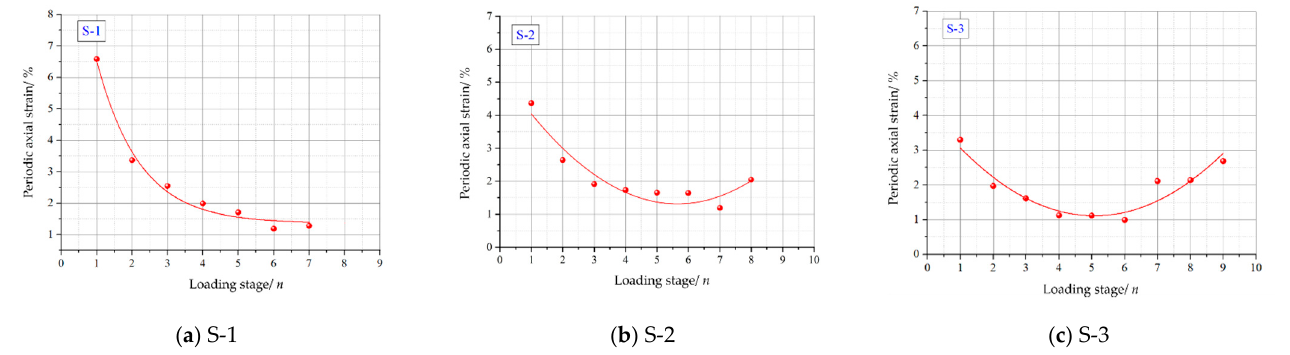
Figure 8. The change rule of axial strain increment corresponding to each loading stage for S-1, S-2 and S-3. Table 1. The periodic axial strain of crushed mudstone sample at each loading stage. The Periodic Axial Strain ε (%) Particle Size